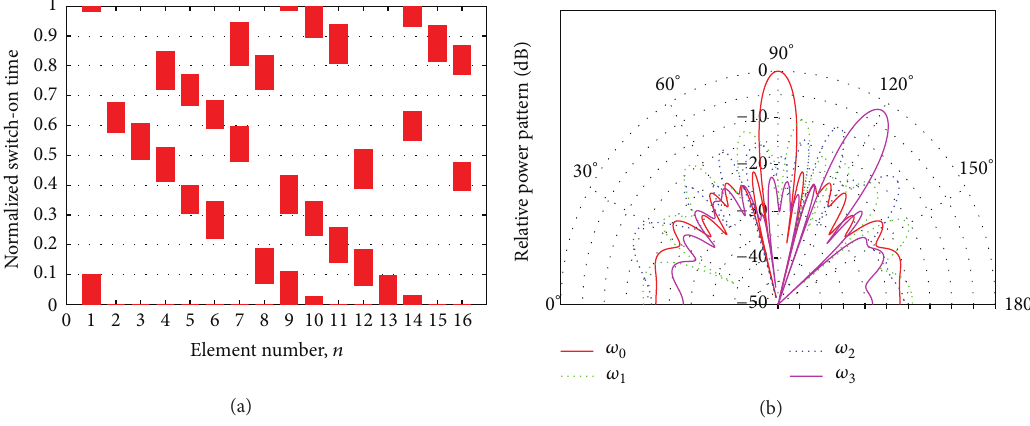
Figure 8: Multipulse waveform, 𝑄 = 3 —multibeam sum pattern synthesis at 𝜔 0 and 𝜔 3 ( 𝑁 = 16 ; 𝑑 = 𝜆/2 ; 𝜃 𝜔 0 = 90 ∘ ; 𝜃 𝜔 3 = 120 ∘ )—plot of (a) the analytically derived pulse sequence and (b) corresponding power patterns generated at 𝜔 0 , 𝜔 1 , 𝜔 2 , and 𝜔 3 .